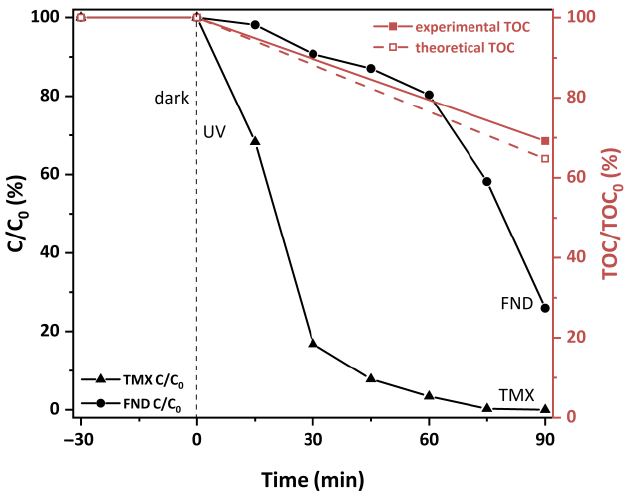
Figure 5. Kinetics of photocatalytic degradation and TOC removal of TMX and FND mixture (comparison with theoretical TOC removal of each pesticide individually) using titania P25 (UV-A irradiation, 5 ppm TMX and 5 ppm FND concentrations, 0.1 g/L TiO 2 , natural pH, 25 °C).